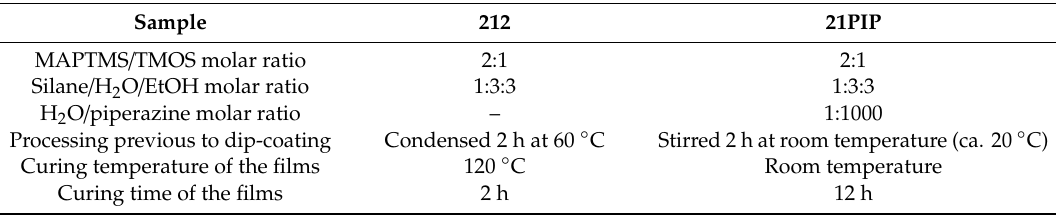
Table 1. Experimental details used for preparation of the modified sol–gel films. Sample 212 21PIP MAPTMS / TMOS molar